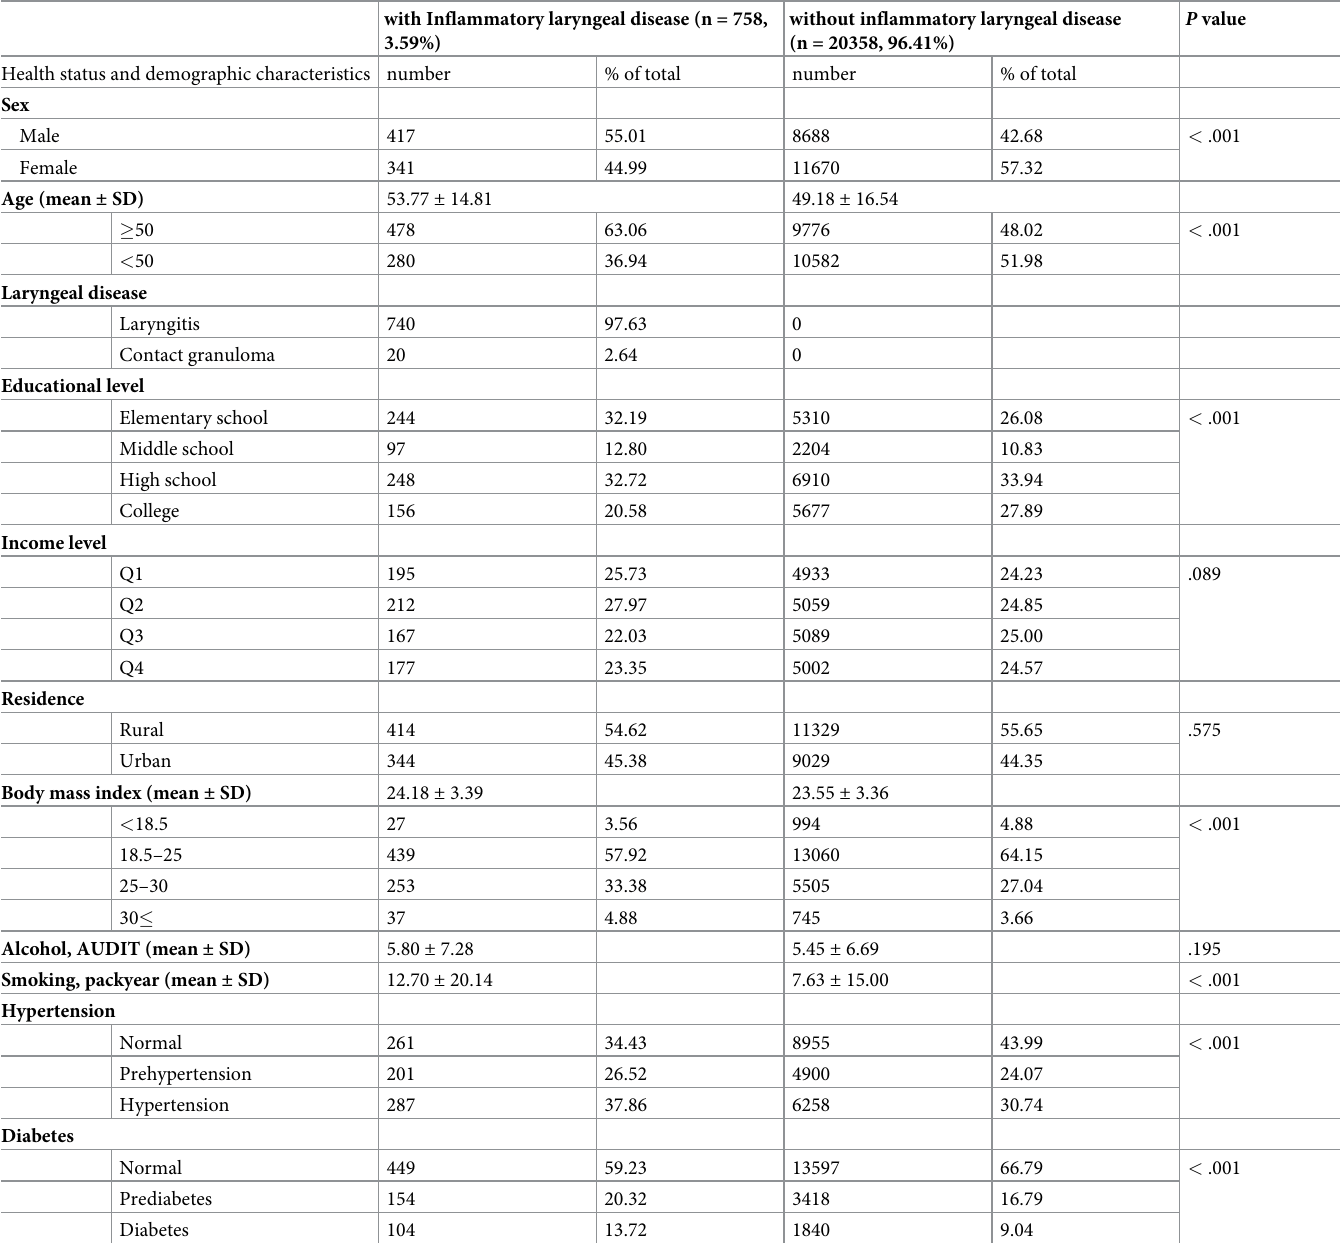
Table 1. Characteristics of participants with and without ILD.